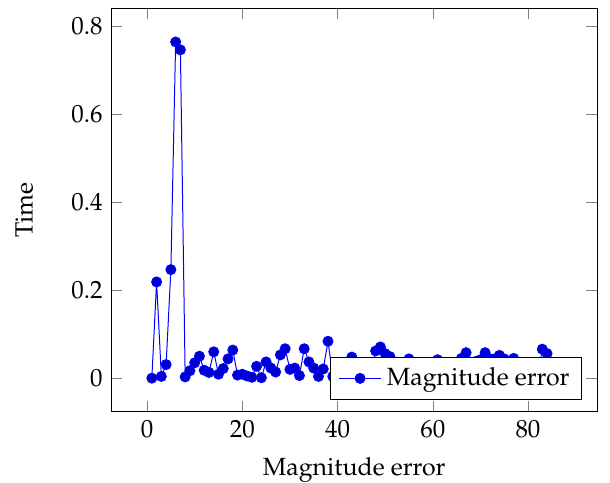
Figure 28. Data showing combined effort of the agents.